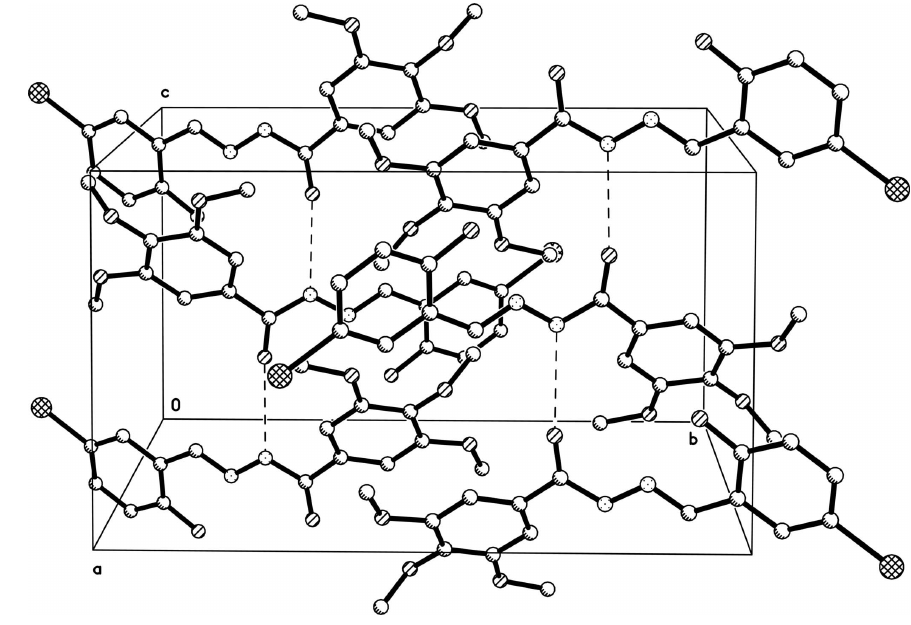
The packing of (I), showing the intermolecular hydrogen-bonded extended network. ( E )- N ′ -(5-Bromo-2-hydroxybenzylidene)-3,4,5-